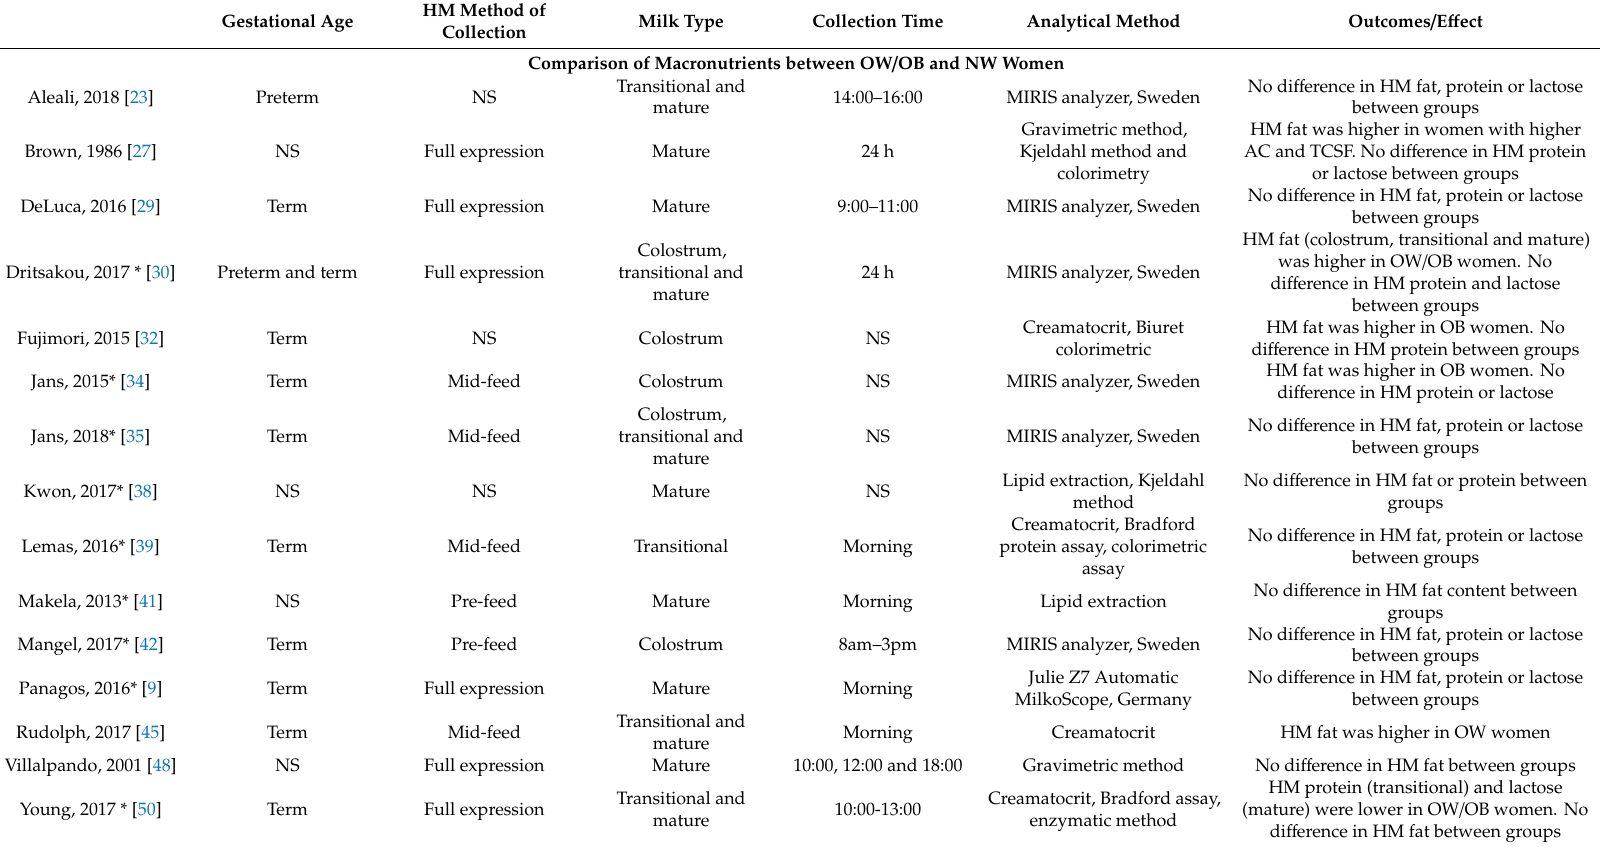
Table 2. E ff ect of maternal obesity on human milk macronutrient composition: key findings 1,2